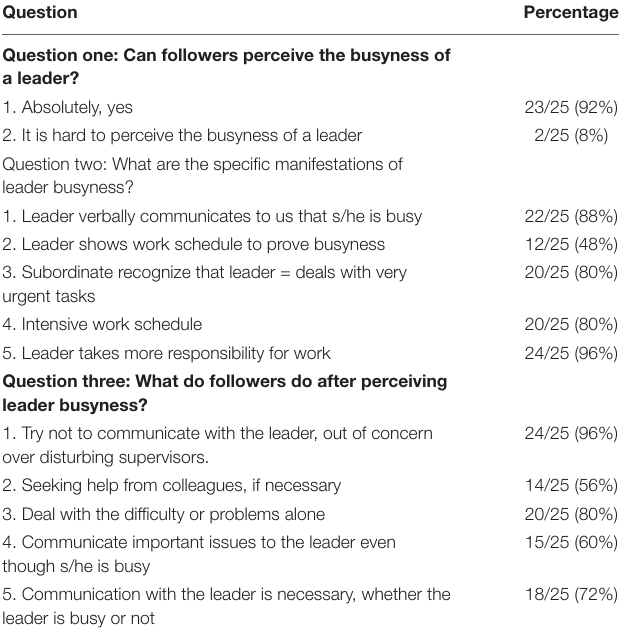
TABLE 1 | Interview